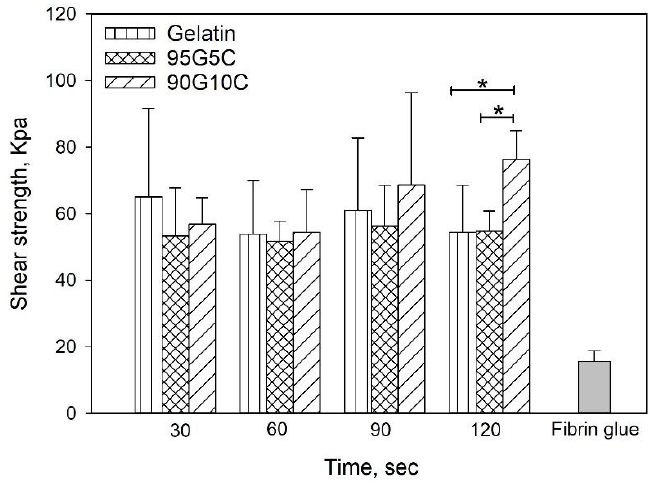
Figure 5. Effects of irradiation time and composition on shear strength. After 100 µ L of the mixed solution was applied to the porcine skin strips, which resulted in an overlap area of 1 cm 2 . The overlap area was irradiated using an LED curing light for a designed time. Data are presented as the mean ± SD (n = 9) and were analyzed using the nonparametric Kruskal-Wallis H-test. Differences of p < 0.05 were considered statistically significant. (*) denotes a significant difference (p < 0.05)